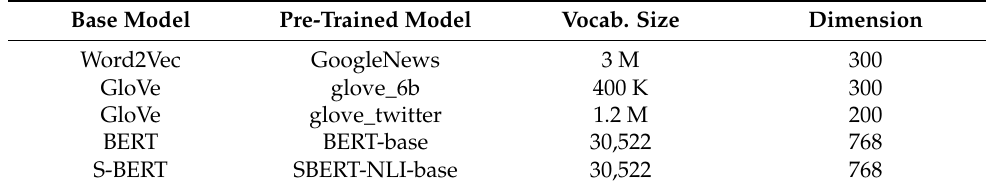
Table 5. Pre-trained Language